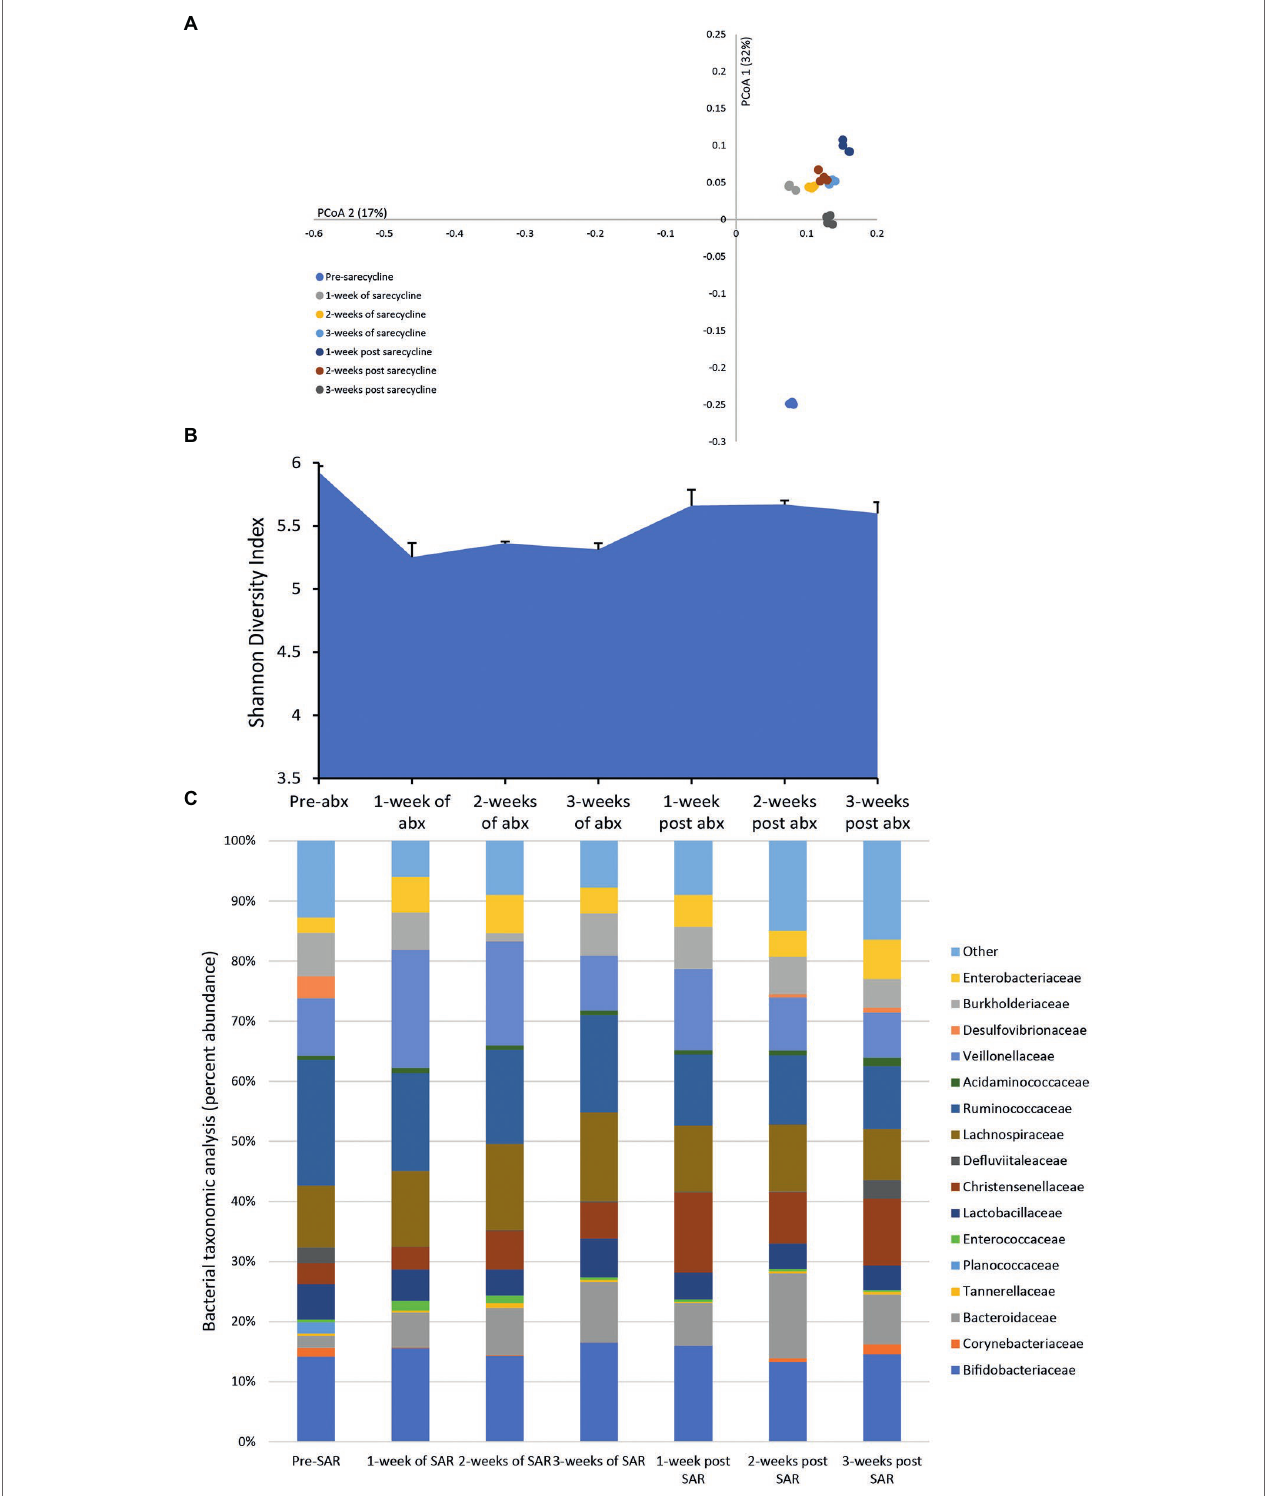
FIGURE 2 | Effect of sarecycline on the human microbiota. Changes to the microbiota profile during each week of sarecycline instillation and the recovery phase shown as a Principal Coordinate Analysis plot (A) . Results shown are four technical replicates. Changes in the microbial diversity after exposure to sarecycline and the recovery phase, as measured by the Shannon diversity index from four technical replicates (B) . Bacterial taxonomic abundance changes in response to sarecycline instillation (C) . Stacked bar graphs are mean percent abundance, from four technical replicates, analyzed from 16S rRNA